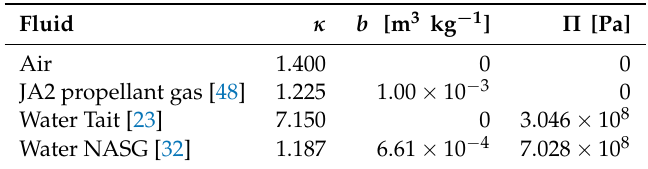
Table 1. Properties of the considered fluids.